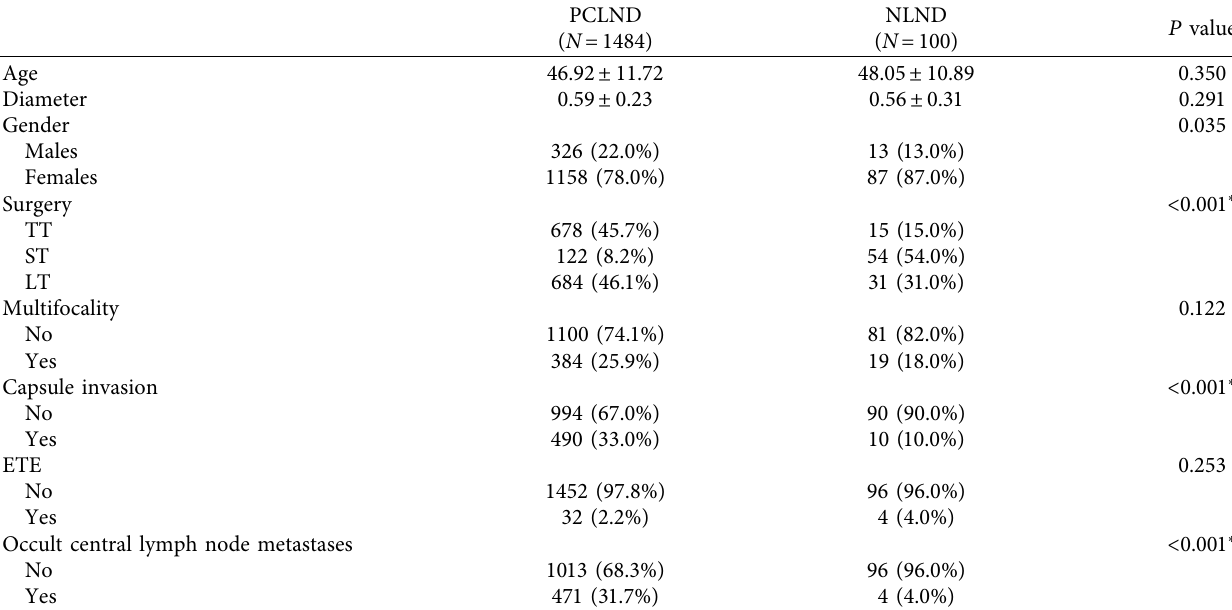
Table 2: Comparison of clinical and pathological features between PCLND and NLND groups.